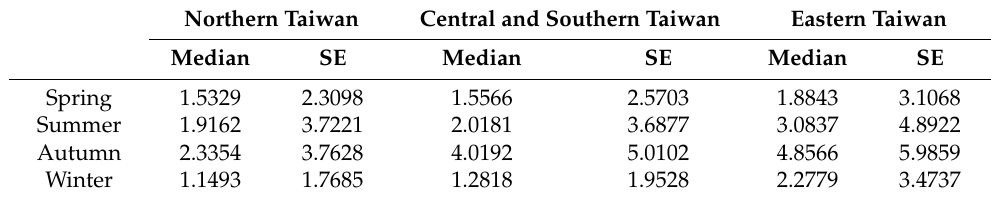
Table 2. The medians and standard errors of OR were derived from the Bayesian conditional logistic regression model for Northern Taiwan, Central and Southern Taiwan, and Eastern Taiwan in four